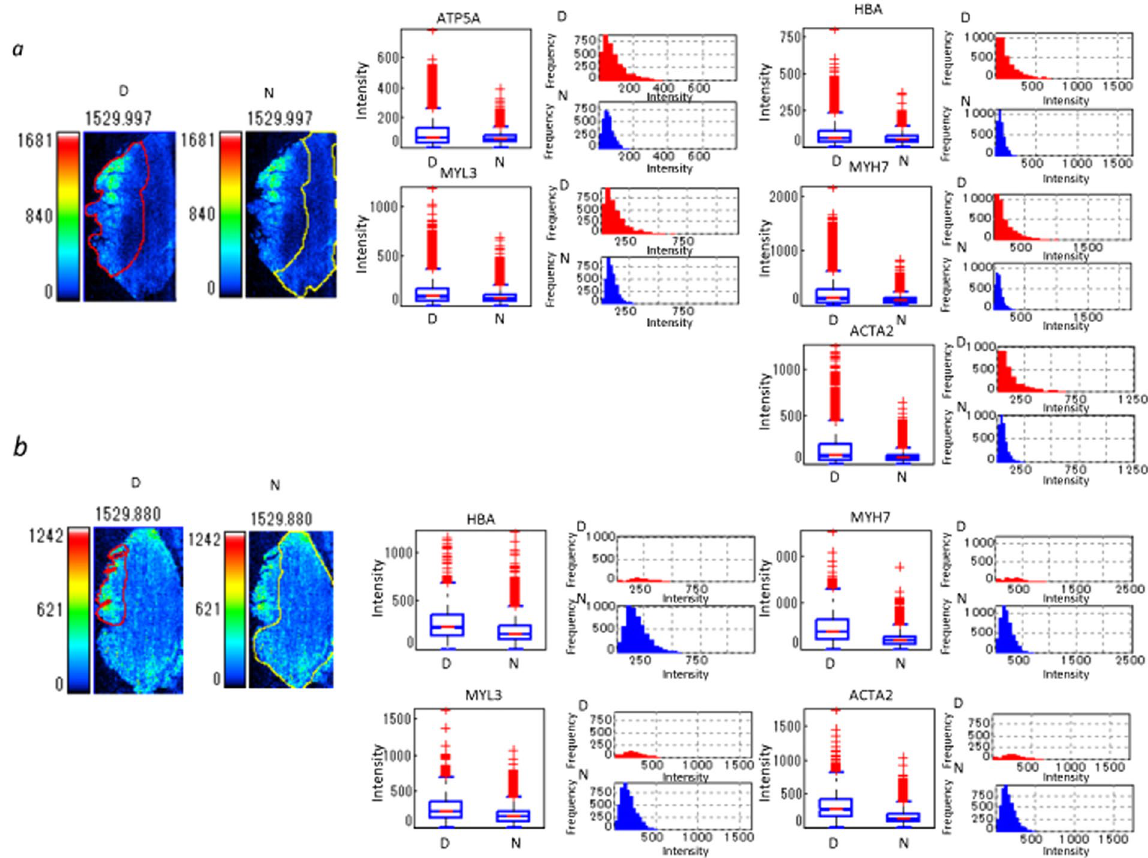
Figure 5. Quantification of peptides in infarcted and healthy areas by ROI analysis. The box plot shows differences and the distribution of intensity of all pixels in a m/z image between infarcted and healthy area. Box plot: upper horizontal line of box, 75 th percentile; lower horizontal line of box, 25 th percentile; horizontal bar within box, median; upper horizontal bar outside box, 90 th percentile; lower horizontal bar outside box, 10 th percentile. The histogram shows differences and the frequency of intensity of all pixels of the m/z image between infarcted and healthy areas. The histogram vertical axes represent the frequency of pixels. The horizontal axes represent intensity. ( a ) Sample 1, ( b ) sample 2. The two photos on the left represent individual ROIs. The red lines demarcate the border of the ROI for the endocardial infarcted lesion ( D ) in the left side of the tissues and of the residual normal area ( N ) in the right side of intact area. The yellow lines demarcate the ROI of the healthy